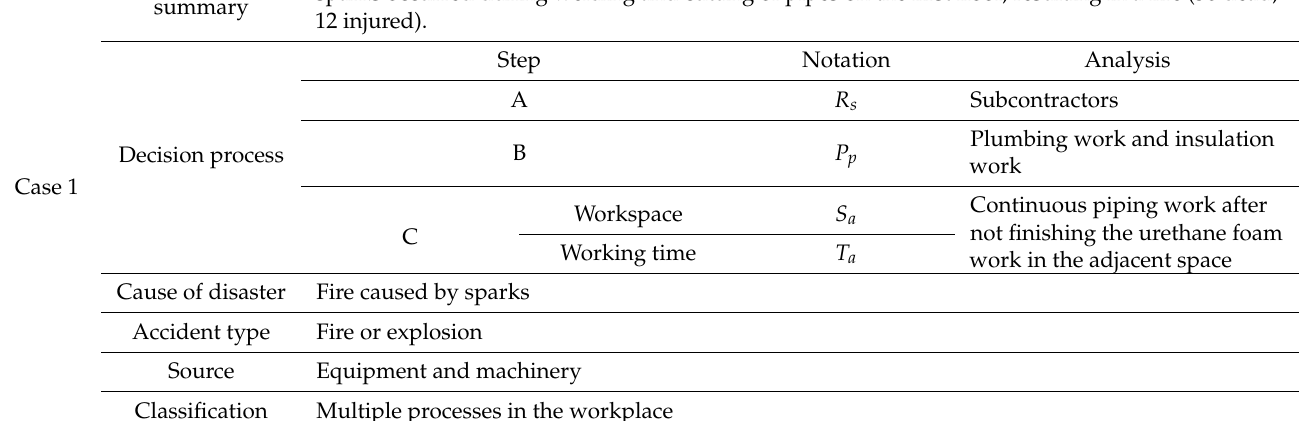
Table 3. Representative actual cases of the accident caused by multiple processes in the workplace—